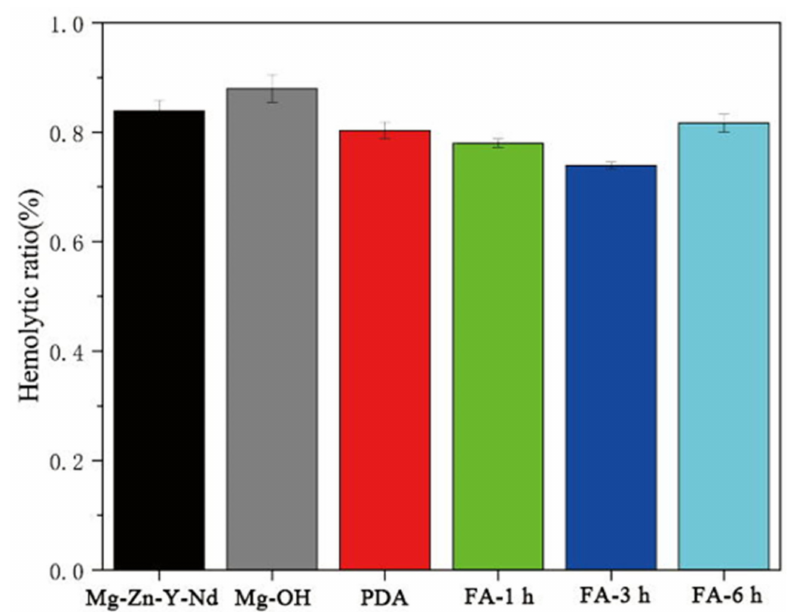
Figure 9. Hemolysis rate of each sample (mean ± SD, n = 3). As shown in Figure 10, the numbers of adhesion and denaturation of fibrinogen (FGN) on the Mg alloy and alkali heat sample were larger, and the numbers of adhesion and denaturation of FGN after fixing FA were greatly reduced. The order of FGN adhesion from largest to smallest was Mg-OH > Mg-Zn-Y-Nd > Fa-1 h > Fa-3 h > Fa-6 h > PDA. The order of FGN denaturation quantity from largest to smallest is Mg-Zn-Y-Nd > Mg-OH > Fa-6 h > PDA > Fa-3 h > Fa-1 h. This indicated that PDA/FA coating can inhibit the adhesion and denaturation of FGN.